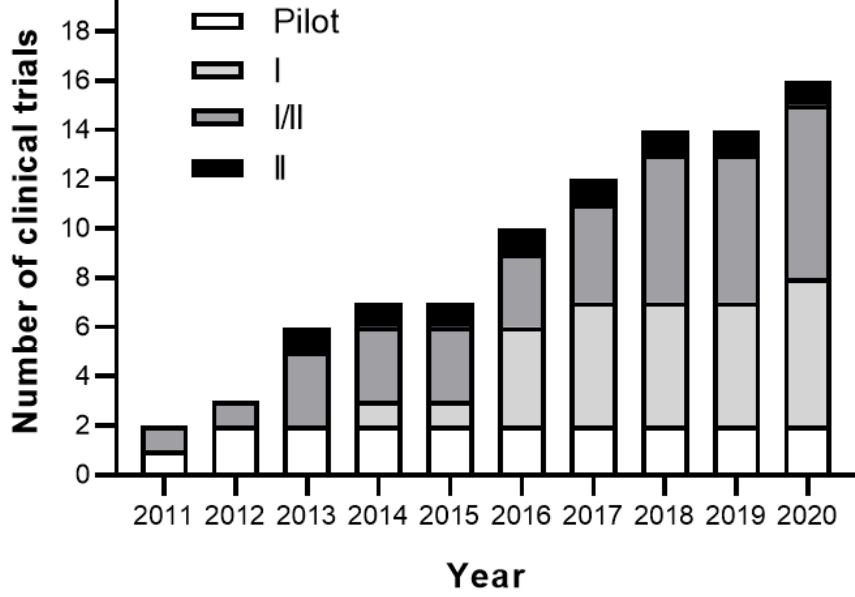
Figure 3. Cumulative number and phase of registered clinical trials with MSC-based therapy in RA patients according to the year of registration in ‘ www.ClinicalTrials.gov ’ and ‘ Pubmed ’ databases.